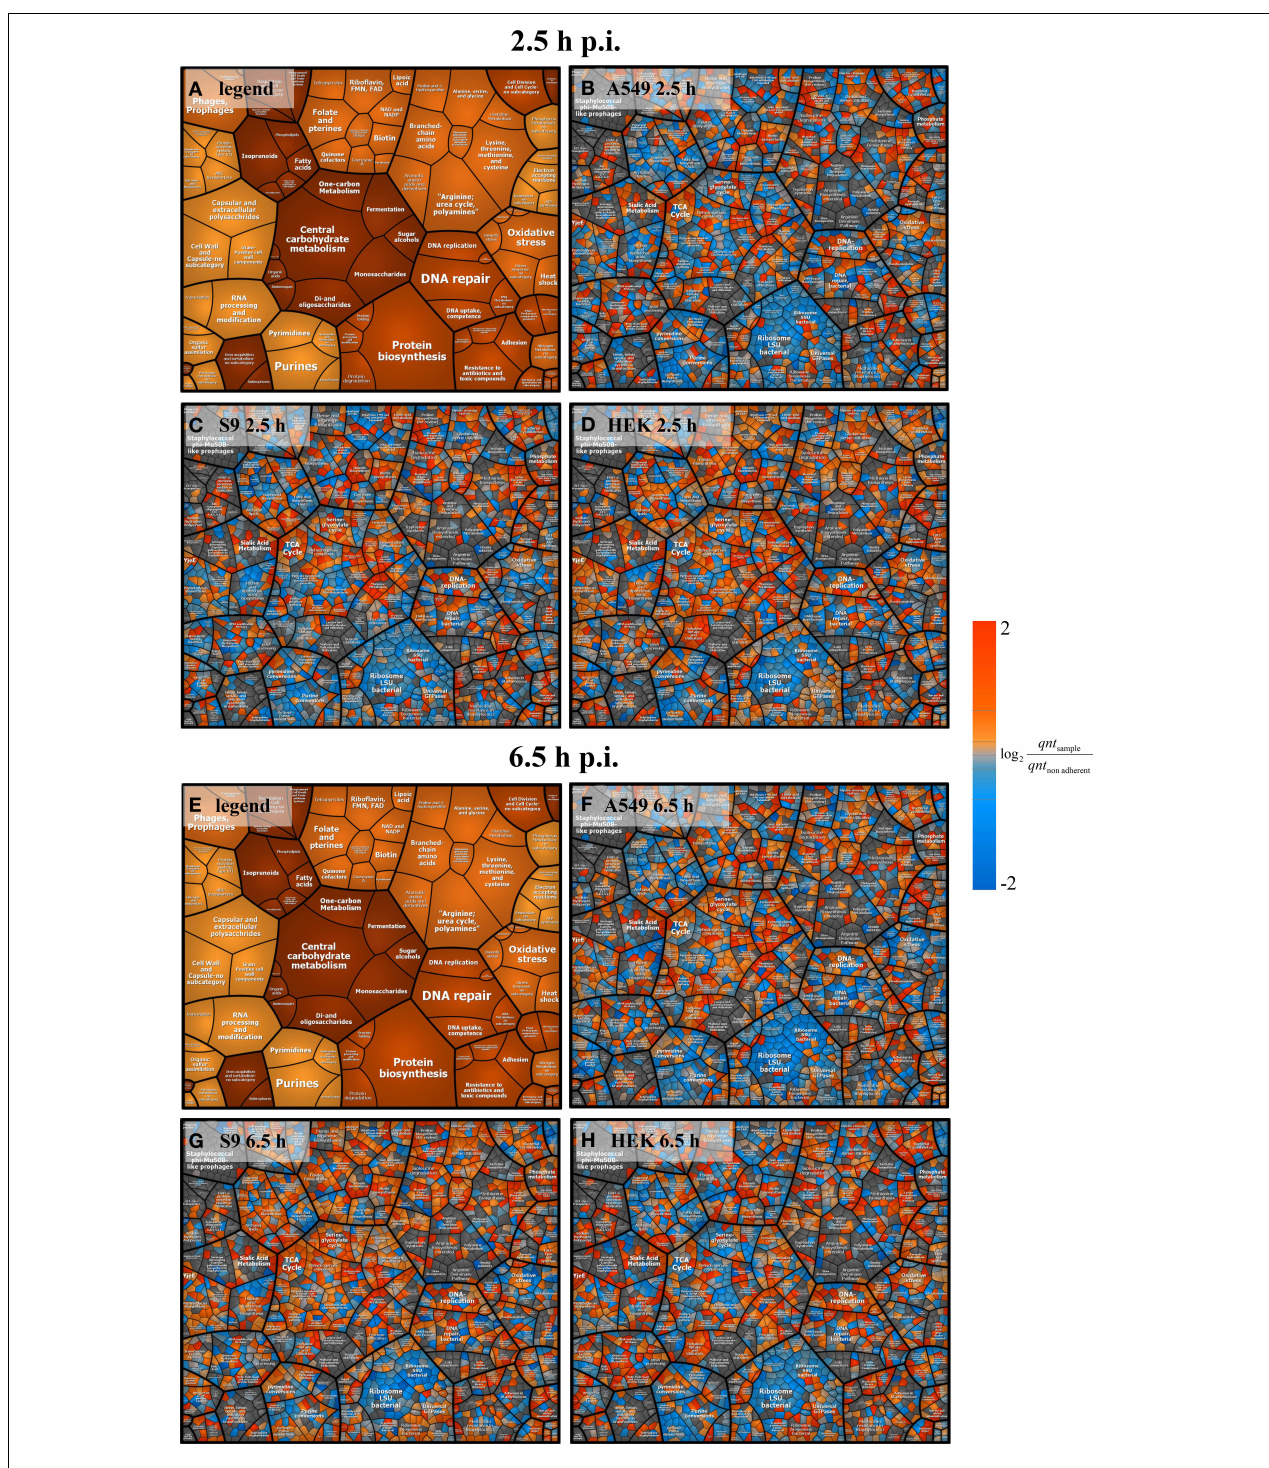
cells). Data at 6.5h p.i. are shown in panel (F) (A549 cells), panel (G) (S9 cells), and panel (H) (HEK 293 cells). Blue spots indicate lower levels in the internalized bacteria compared to the non-adherent control; red colors represent higher levels of proteins in response to internalization compared to the non-adherent control. Average values from three independent biological samples are